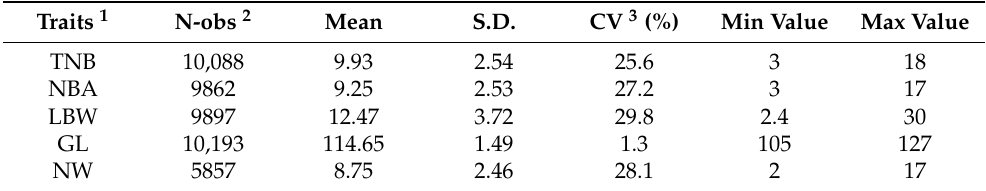
Table 1. Descriptive statistics for five reproductive